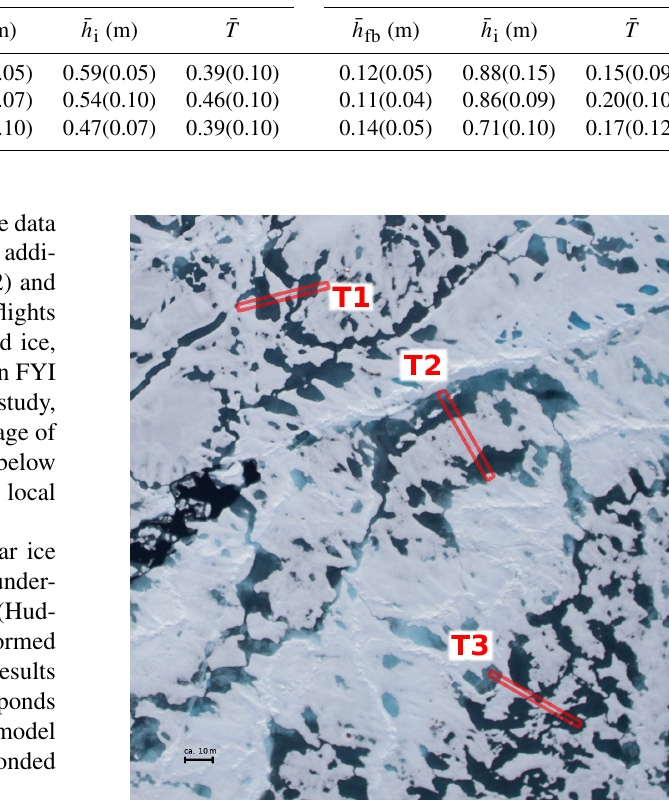
Table 1. Measurement summary for all measurements along the transects. ¯ h p is mean pond depth, ¯ h i is mean ice thickness, ¯ h fb is mean freeboard, and ¯ T is mean bulk transmittance (Eq. 4) in the range 400 to 900nm. Numbers in parentheses indicate 1 standard deviation. N p /N b is the number of spectra collected along the transect under ponded and bare ice, respectively. Positions are approximate. Ponded ice Bare ice